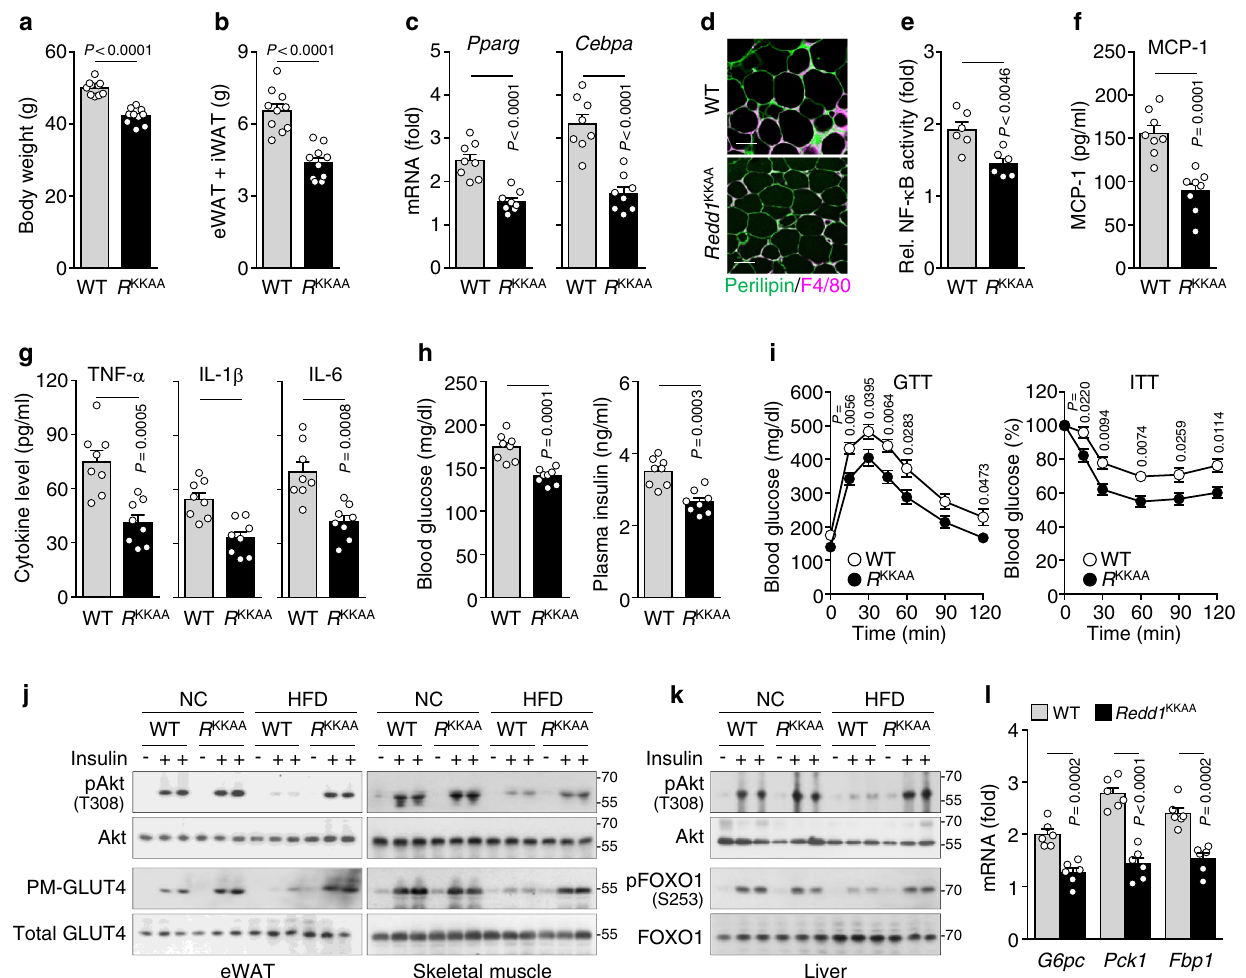
Fig. 7 | HDF-induced obesity and metabolic phenotypes are prevented in Red- d1 KKAA mice. a Weight gain in WT and Redd1 KKAA mice after being fed HFD for 16 weeks ( n =10 per group). b eWAT and iWAT mass measurements in HFD-fed Redd1 KKAA mice and their WT littermates ( n =10 per group). c Expression levels of Pparg and Cebpa in the eWAT of Redd1 KKAA mice and WT littermates fed HFD for 10 weeks ( n =8 per group). d Representative images showing perilipin (green) and F4/80 (purple)staining inthe eWATof HFD-fed Redd1 KKAA mice and WT littermates ( n =5 per group). Scale bar, 100 μ m. e NF- κ B activity in the eWAT from HFD-fed Redd1 KKAA mice and WT littermates ( n =6 per group). f , g Plasma levels of in fl am- matory cytokines in HFD-fed Redd1 KKAA mice and WT littermates ( n =8 per group). h Fasting plasma levels of glucose and insulin in HFD-fed Redd1 KKAA mice and WT